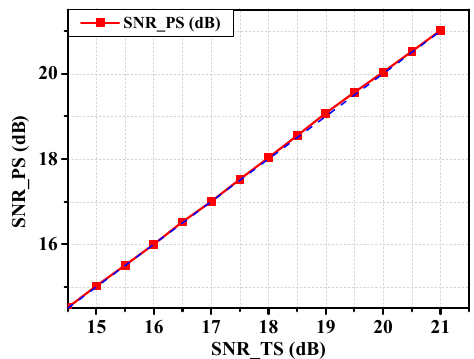
Figure 6. The PS signal SNR (SNR_PS) and training sequence SNR (SNR_TS).